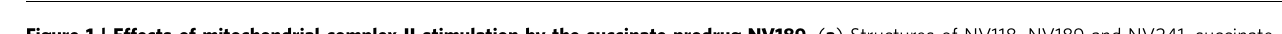
Figure 1 | Effects of mitochondrial complex II stimulation by the succinate prodrug NV189. ( a ) Structures of NV118, NV189 and NV241, succinate highlighted in red. ( b ) Respiration in platelets (plts) with rotenone-induced mitochondrial complex I (CI) inhibition. ( c ) ATP-generating respiration in platelets. ( d ) Mitochondrial membrane potential in complex I-inhibited platelets, ratio of basal TMRM fluorescence, n ¼ 4. ( e ) Respiration in platelets with FCCP-induced uncoupling. ( f ) Respiration in digitonin-permeabilized platelets. ( g ) Effect on respiration in platelets with addition of the cell-permeable complex II inhibitor NV161, * indicate significant difference between NV161 and vehicle, n ¼ 4. ( h ) Structure of NV161, malonate highlighted in red. ( i ) Respiration in peripheral blood mononuclear cells (PBMCs) with rotenone-induced CI inhibition, n ¼ 4. ( j ) Convergent respiration in PBMCs, n ¼ 4, * indicate significant difference between pre and post dosing. ( k ) Respiration in human heart muscle fibres (HHMFs), n ¼ 5. ( l ) Lactate:pyruvate ratio in PBMCs at baseline, after rotenone CI inhibition and after treatment with NV189, n ¼ 4. * indicates significant difference using Friedmans non-parametric paired test with Dunn’s multiple comparisons test of all groups against control. For three data points, pyruvate was below detection limit and the estimated lower-quantification limit was used for calculating the ratio. ( m ) Lactate accumulation in 2ml buffer containing 400 (cid:3) 10 6 platelets, incubated with or without rotenone, antimycin A and NV189, n ¼ 5. ( n ) Lactate production in platelets, data quantification from previous panel. Mean with 95% confidence interval. All respirometric experiments in human platelets were performed with n ¼ 6 individuals donors if not otherwise stated. All data presented as mean and s.e. if not otherwise stated. In all experiments, blood cells from separate donors are used for each n . * P o 0.05, ** P o 0.01, *** P o 0.001 (two-tailed paired or unpaired Student’s t -test as appropriate, difference between test compound and control if not otherwise